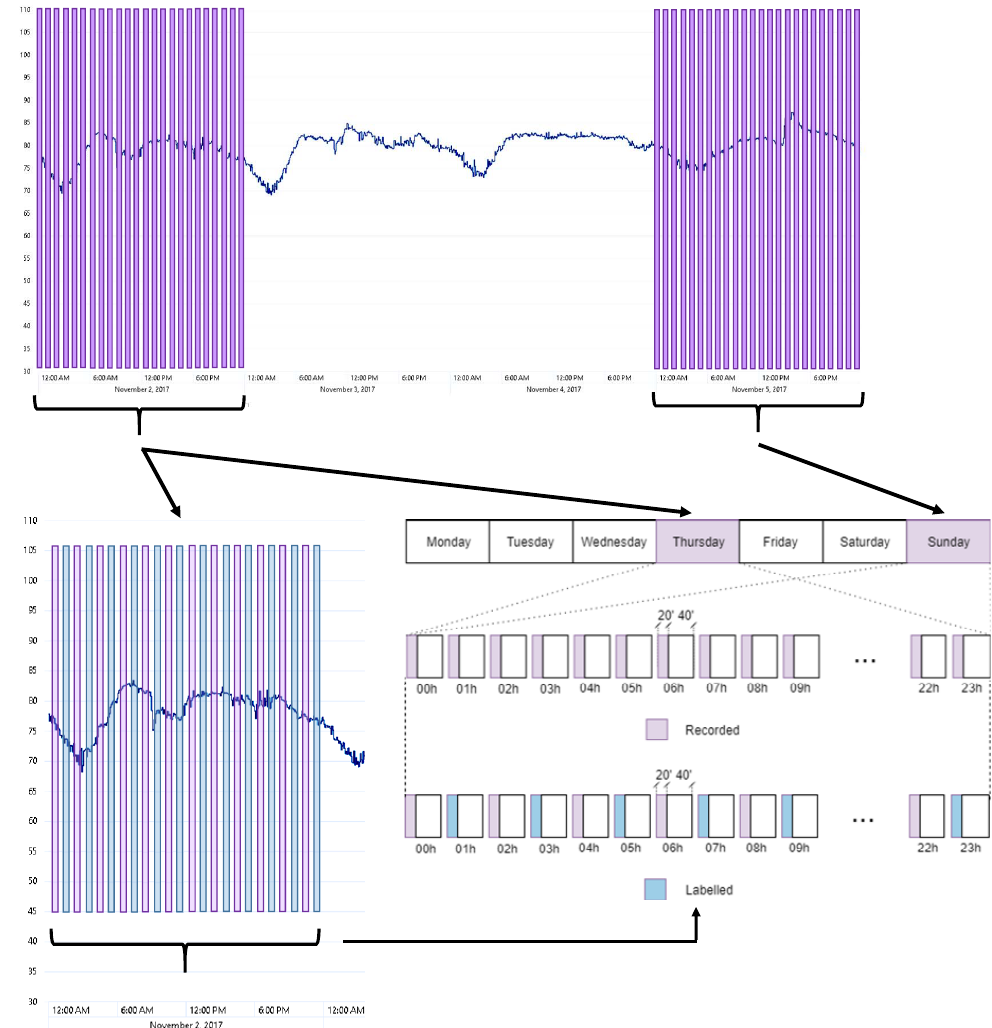
Figure 3. Daily curve of L Aeq for sensor hb147 for the 2nd and the 5th of November 2017, and the recordings conducted. Diagram of the recording days and duration for each sensor, and scheme of the labeled files to build the